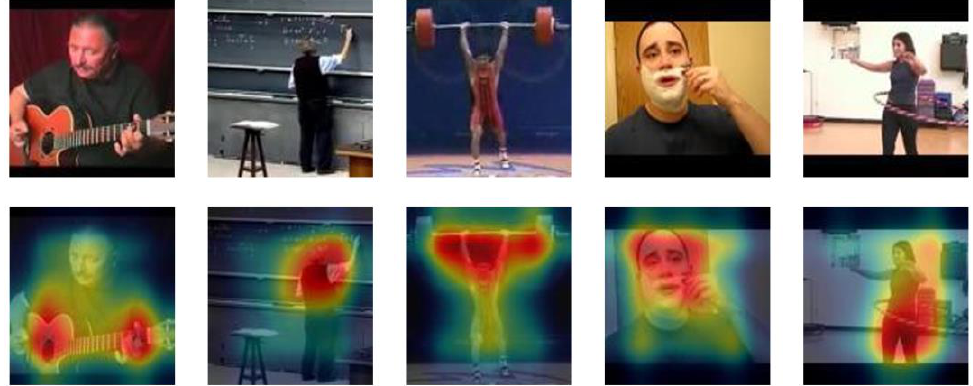
Figure 4. Attention visualization on random video samples (UCF-101) based on an unsupervised pre- trained model. (For each column, the first row represents input video and the second row represents its neural